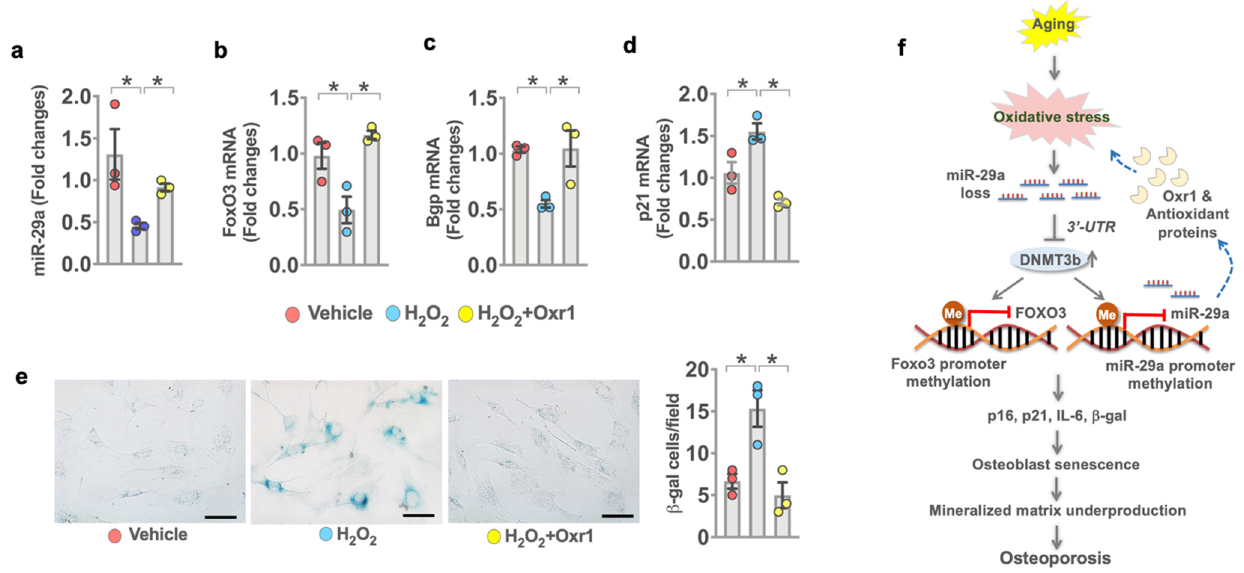
Figure 8. Effects of Oxr1 recombinant protein on miR-29a signaling and senescence in MC3T3-E1 osteoblasts. Oxr1 attenuated H 2 O 2 -mediated loss in miR-29a ( a ), FoxO3 ( b ), and Bgp ( c ) expression and the inhibited p21 expression ( d ) of murine osteoblasts. Orx1 reversed H 2 O 2 -induced SA- β -gal activity ( e ); scale bar, 15 μ m. A significant difference (asterisk *) of investigations (mean ± standard error, n = 3 experiments) was analyzed using an ANOVA test and a Bonferroni post hoc test. Schematic graphs showing miR-29a protection against oxidative stress, osteoblast senescence, and osteoporosis. miR- 29a targets Dnmt3b-mediated Foxo3 promoter hypermethylation and increased antioxidant protein Oxr1, compromising age-induced Foxo3 loss, oxidative stress, osteoblast senescence, and osteoporosis development ( f ).